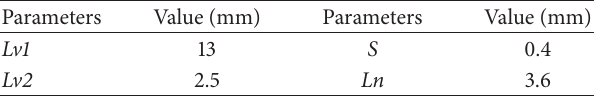
Table 2: Optimized parameters of the notch